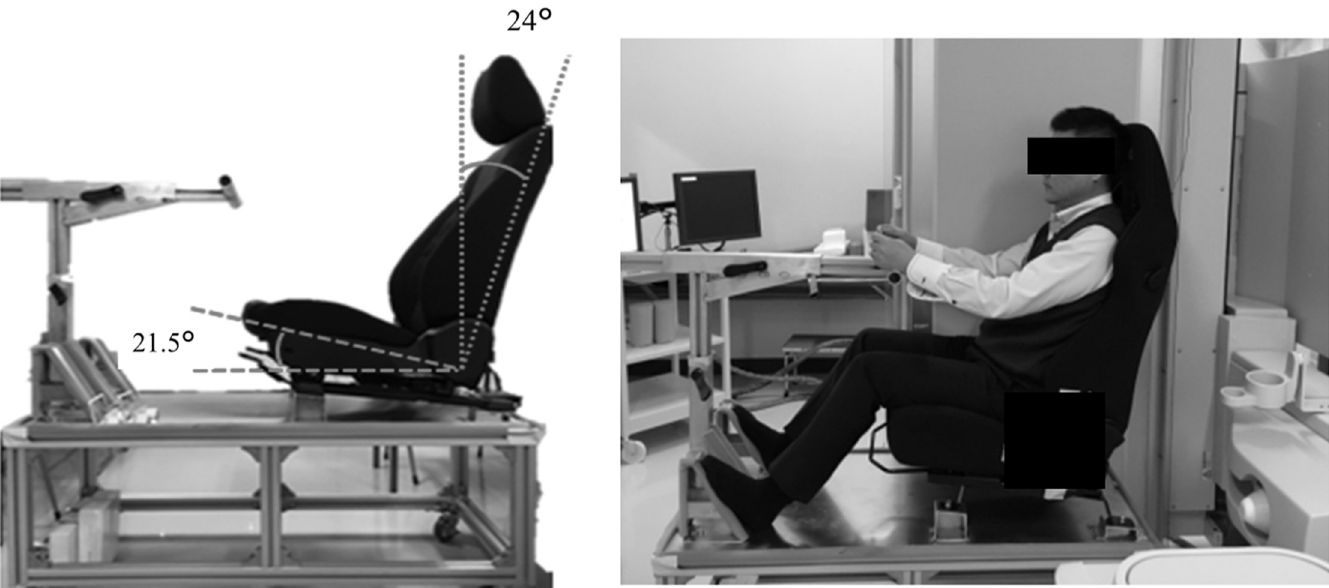
Fig 1. The positions taken by study participants for seat ( left ) and sitting position ( right